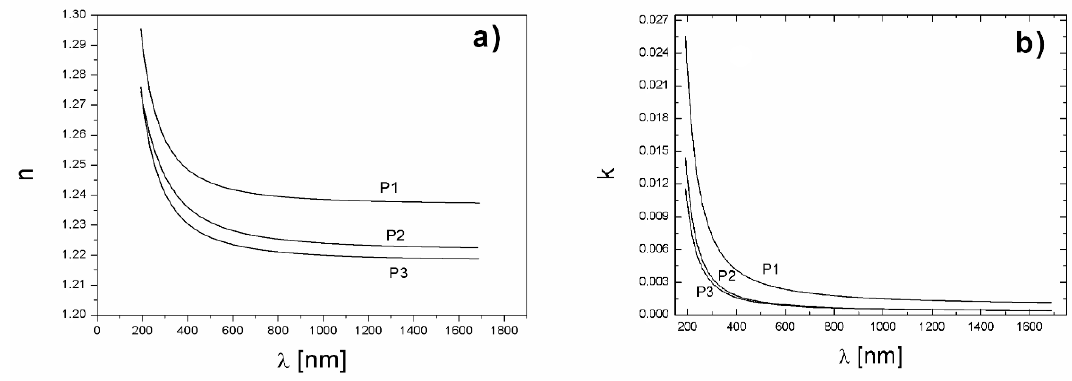
Figure 5. Spectral dependence n ( λ ) ( a ) and k ( λ ) ( b ) for samples P1, P2, and P3, respectively.